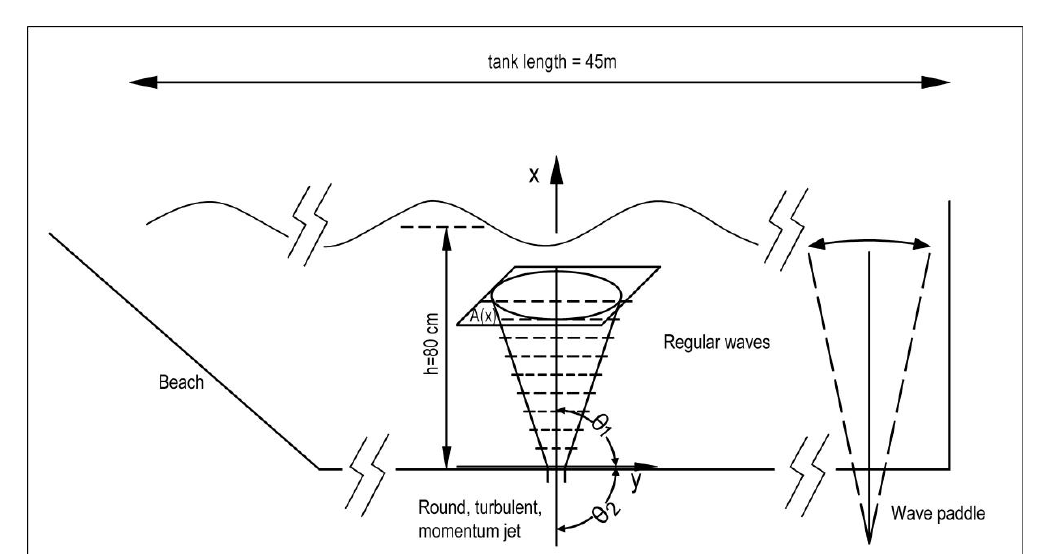
Figure 2. Drawing of the experimental setup.